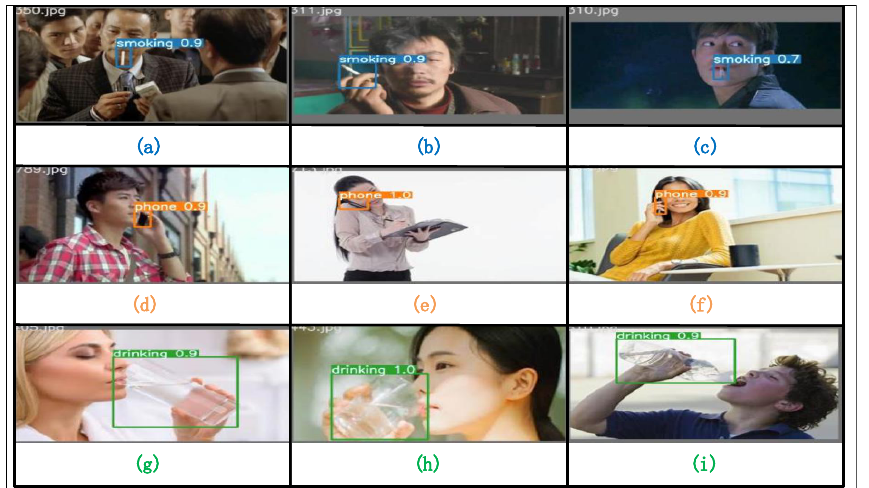
Figure 10. Forecast results. The recognition predicted results of the smoking are shown in subplot ( a – c ). Then, we can see the predicted result of phone from subplot ( d – f ). Finally, subplot ( g – i ) show the results of the identification for